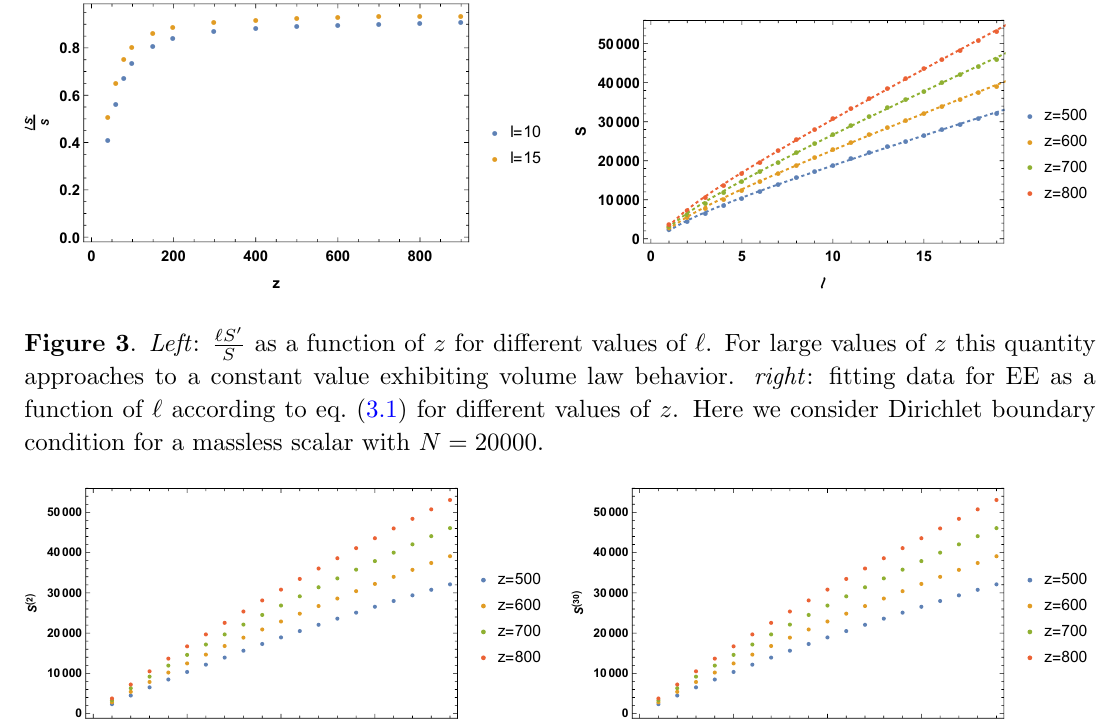
exponents is similar to a certain non-local scalar theory studied in [40]. In (cid:12)gure 4 we have shown that this scaling behavior also happens for Renyi entropies for large values of z